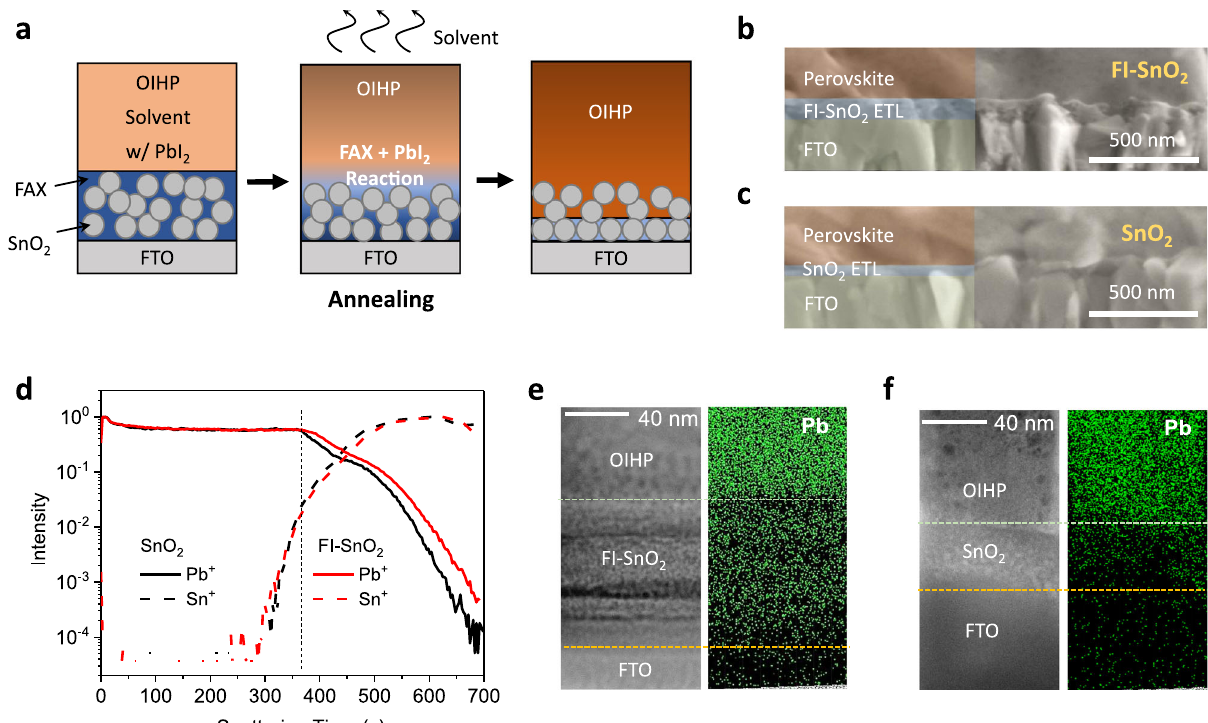
Fig. 2 Characterization of SnO 2 -OIHP interfaces. a Schematic illustration showing the formation process of the OIHP/FI – SnO 2 interface by the reaction between the excess PbI 2 in the OIHP layer and the FA halide in the FI – SnO 2 ETL. Cross-sectional SEM images of OIHP thin fi lms on, b FI – SnO 2 ETL and, c pristine SnO 2 ETL. d TOF – SIMS depth elemental pro fi les of Pb and Sn into the OIHP/FI – SnO 2 and the OIHP/SnO 2 fi lms. Cross-sectional STEM image